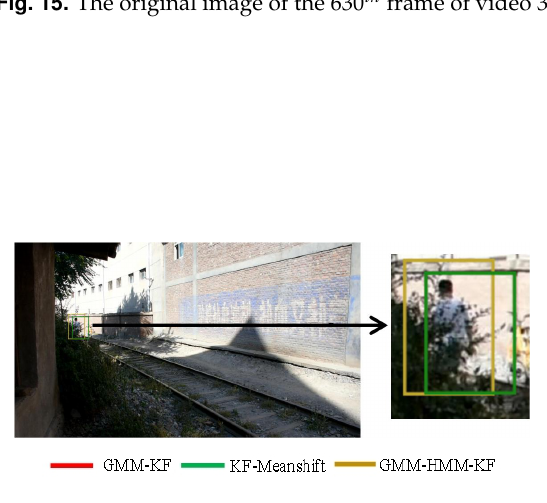
Fig. 16. The results of processing using three algorithms